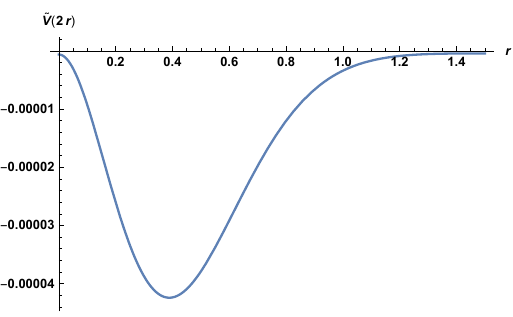
Figure 2 . The shape of the e(cid:11)ective potential ~ V (2 r ) (the sum of eqs. (5.6) and (5.9)) with ! = 0 : 1 and (cid:3) =